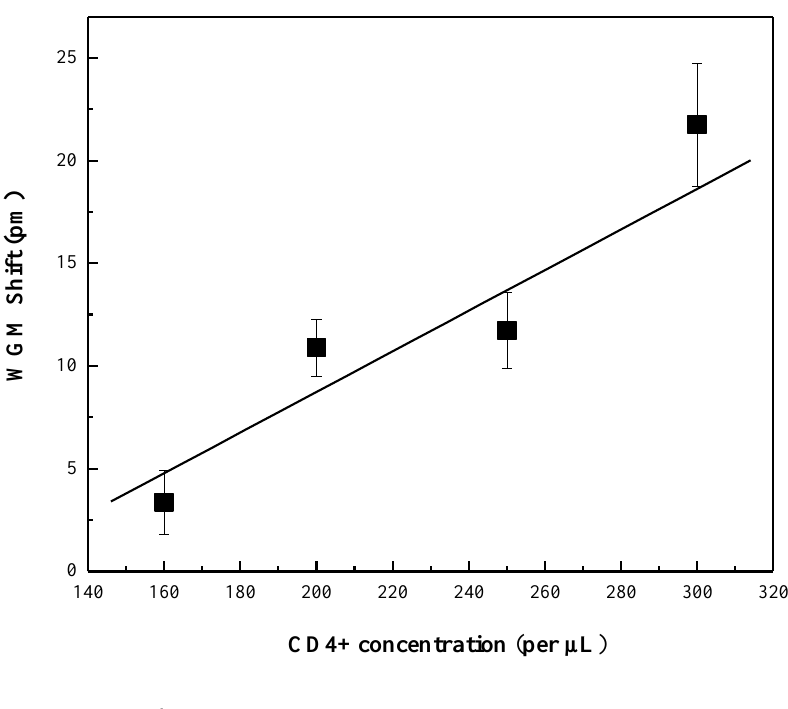
Figure 3. Spectral shift recorded for various concentrations of CD4+ T-Lymphocytes in PBS buffer. Error bars are based on standard deviation obtained from 10